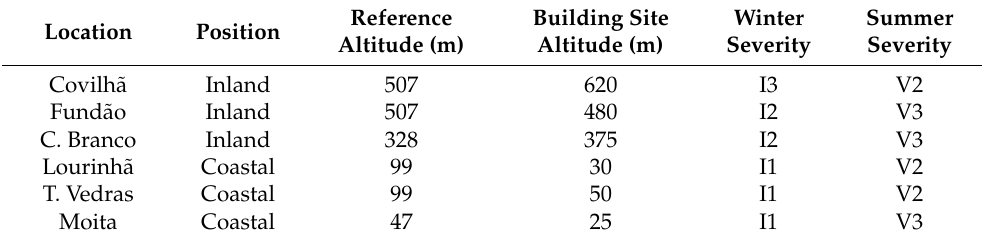
Table 1. Winter and summer adjusted scenarios for each building location.